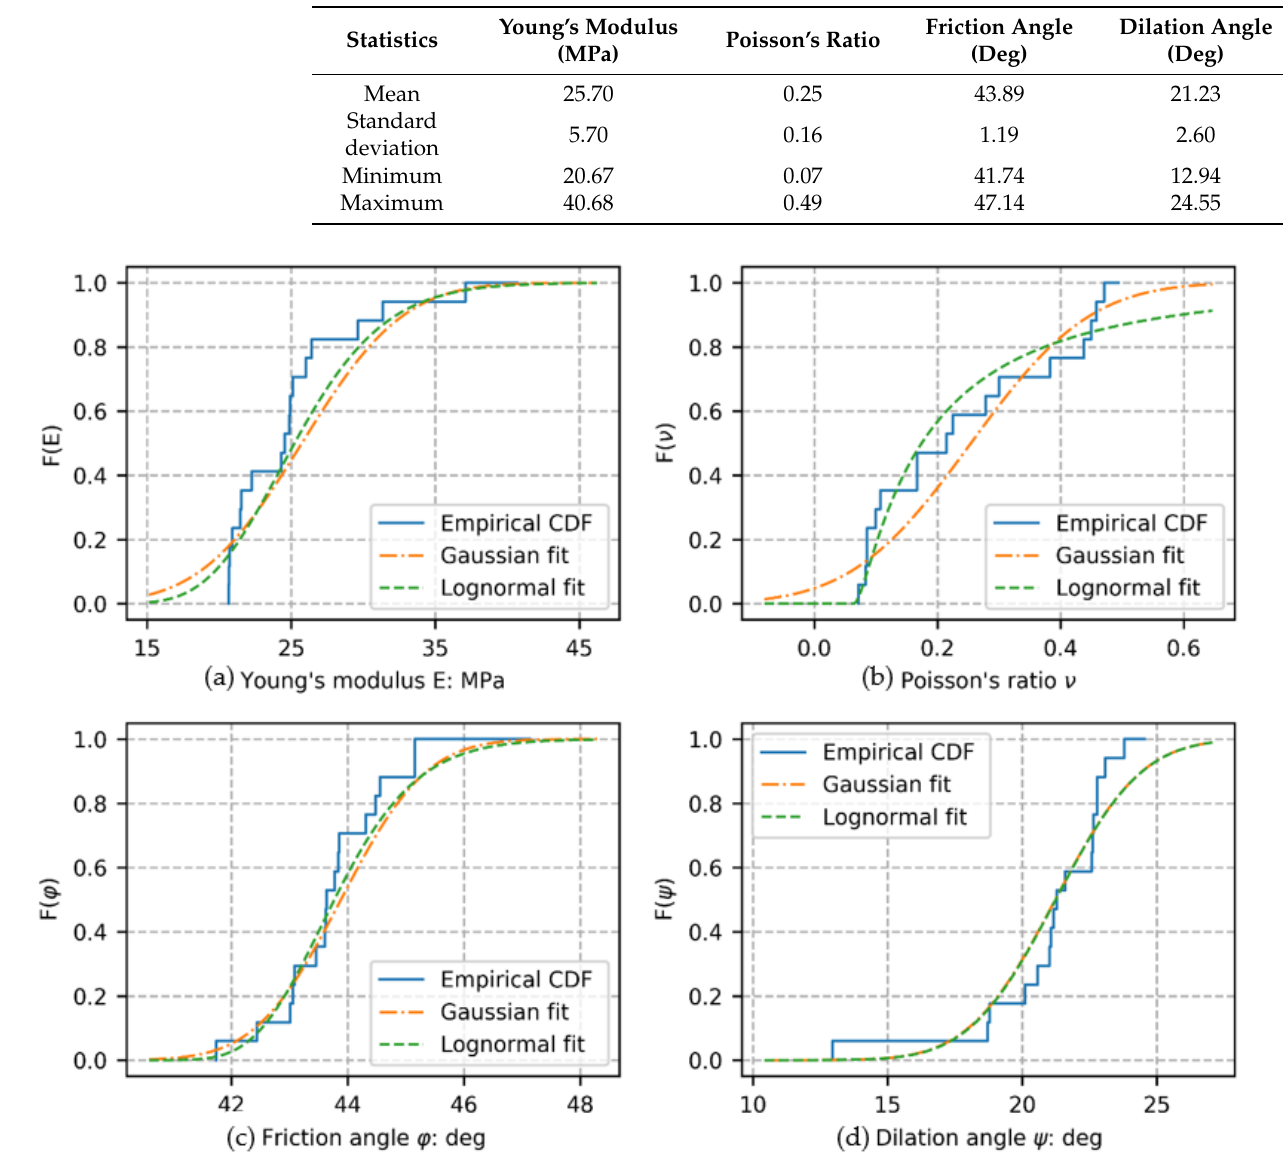
Table 2. First-order statistics of mechanical constitutive parameters.